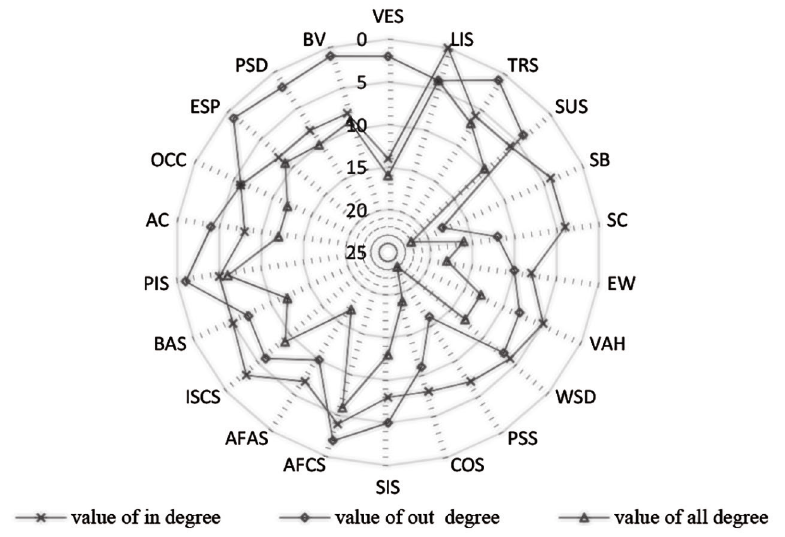
Figure 10. Degree distribution of SPSN